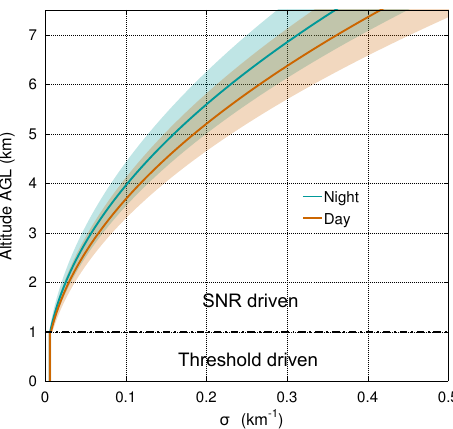
Fig. 12. Extinction profile based on the sensitivity of the PT algo- rithm for average noise levels during a typical daytime and night- time case. The shaded areas represent uncertainty due to lidar ratio variation between 16 sr < S < 25